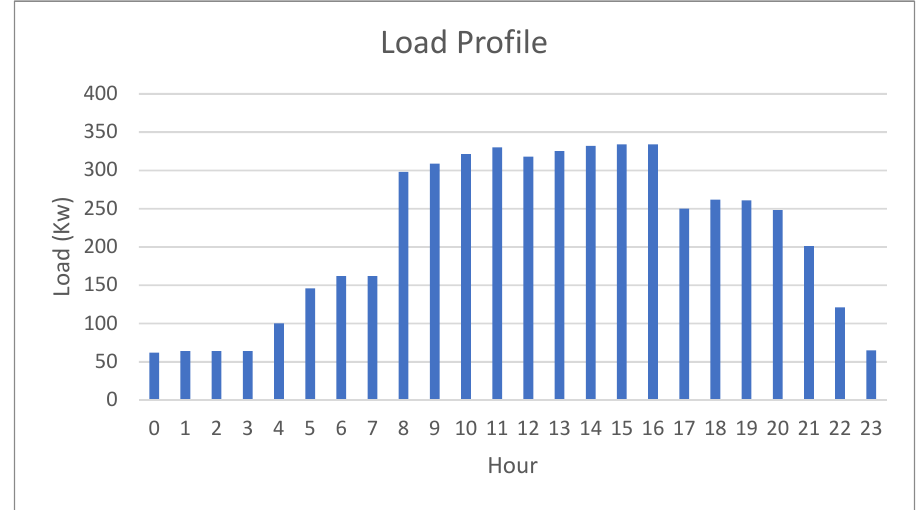
Figure 2. Load profile for Irele community.